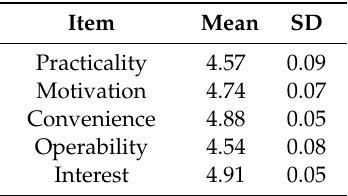
Table 2. Questionnaire survey